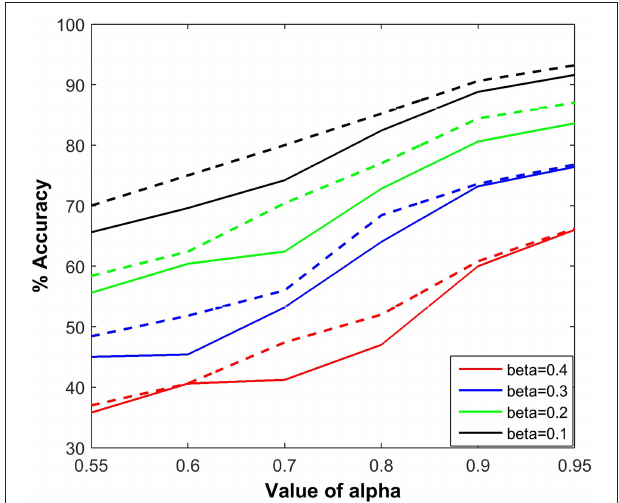
FIGURE 9 | Tracking accuracy of the BEAST framework as a function of α and β . Each point is calculated by taking the mean of 10 different simulations. The probability of background activity, i.e., the presence of distractor is β and the probability of firing of the sensory neuron, either due to a fruit fly or a distractor is α . The performance results are compared for both types of implementations, using stochastic computation framework and using floating point implementation (dotted line).